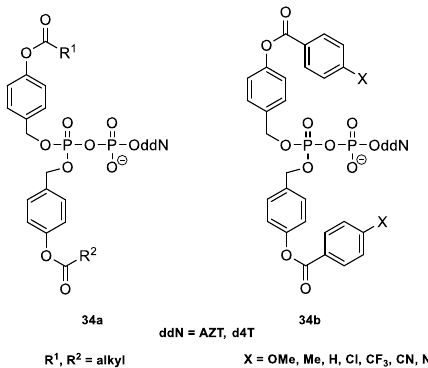
Figure 7. Structures of the developed pronucleotides of Di PP ro type [108].